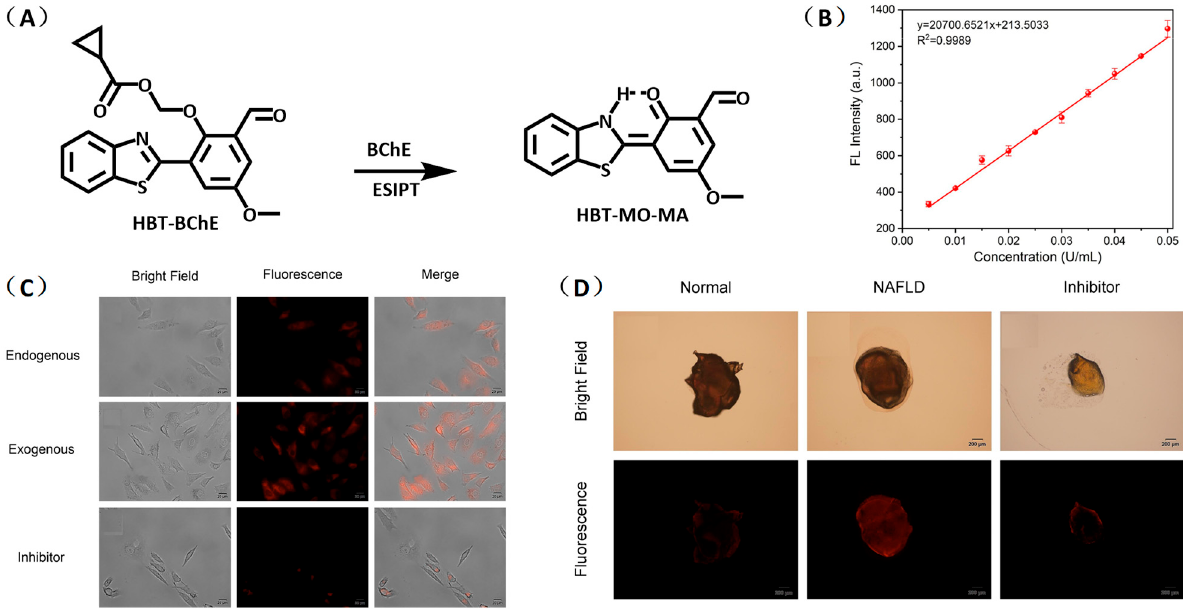
Figure 18. ( A ) Structure and response mechanisms of the probe HBT-BChE for BChE. ( B ) Spectra of HBT-BChE with the BChE catalytic reaction (0.500 U/mL) at 37 °C in 10 mM PBS buffer of pH = 7.4. ( C ) Hela cells imaging of HBT-BChE (10 µ M at 37 ◦ C). ( D ) Part of the liver of zebrafish confocal imaging by HBT-BChE (10 µ M) [48]. Copyright © 2023 Elsevier B.V. All rights